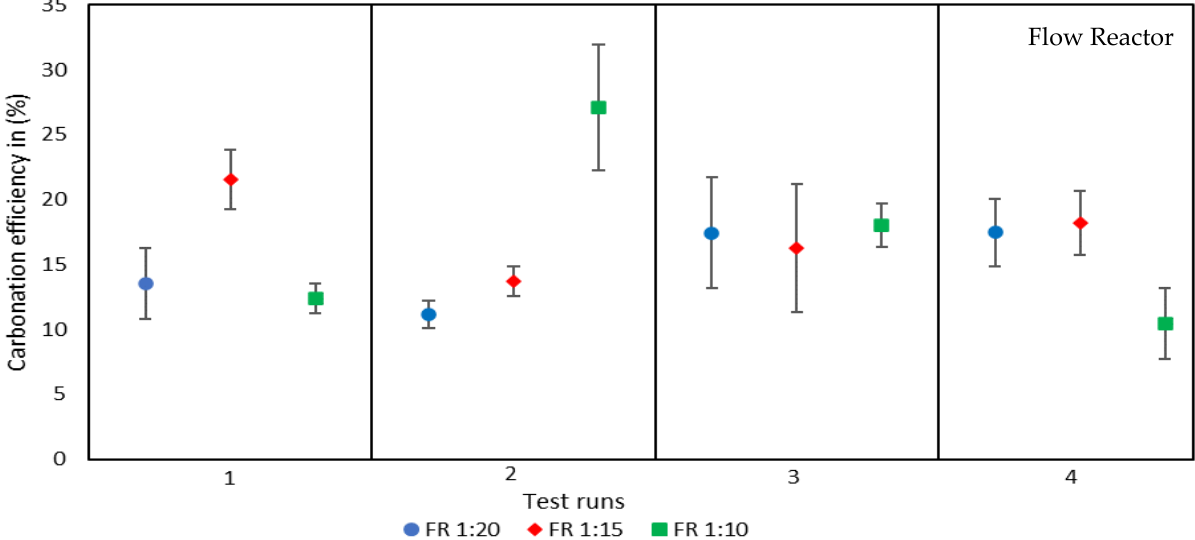
Figure 3. Carbonation efficiency for wood ash in a flow reactor (FR) ( n = 4), circle (blue) for 1:20, rhombus (red) for 1:15 and square (green) for 1:10 ash to water ratio.